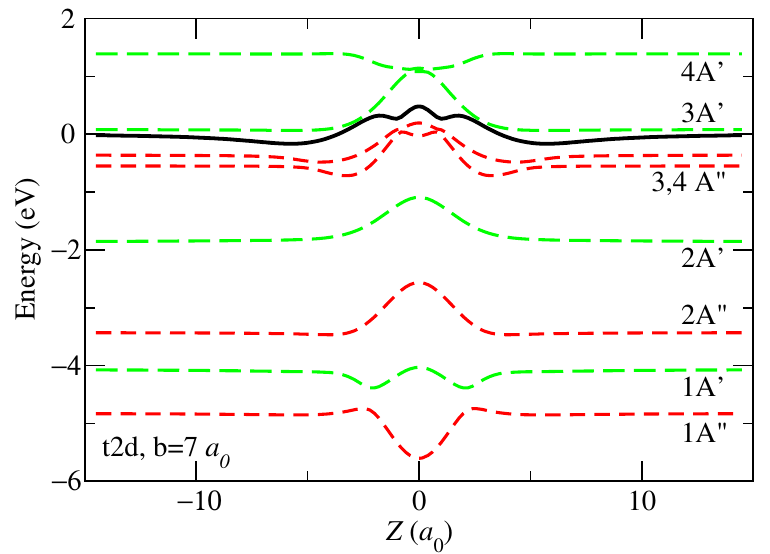
Figure 1. Potential energy curves along the trajectory t2d with impact parameter b = 7 a 0 . The states are labeled according to the electronic state of U + when the projectile is at an asymptotic distance. The energy curve of the entrance channel, corresponding to H + +uracil(X A’), is shown with a black solid line. The CT channels are shown with dashed